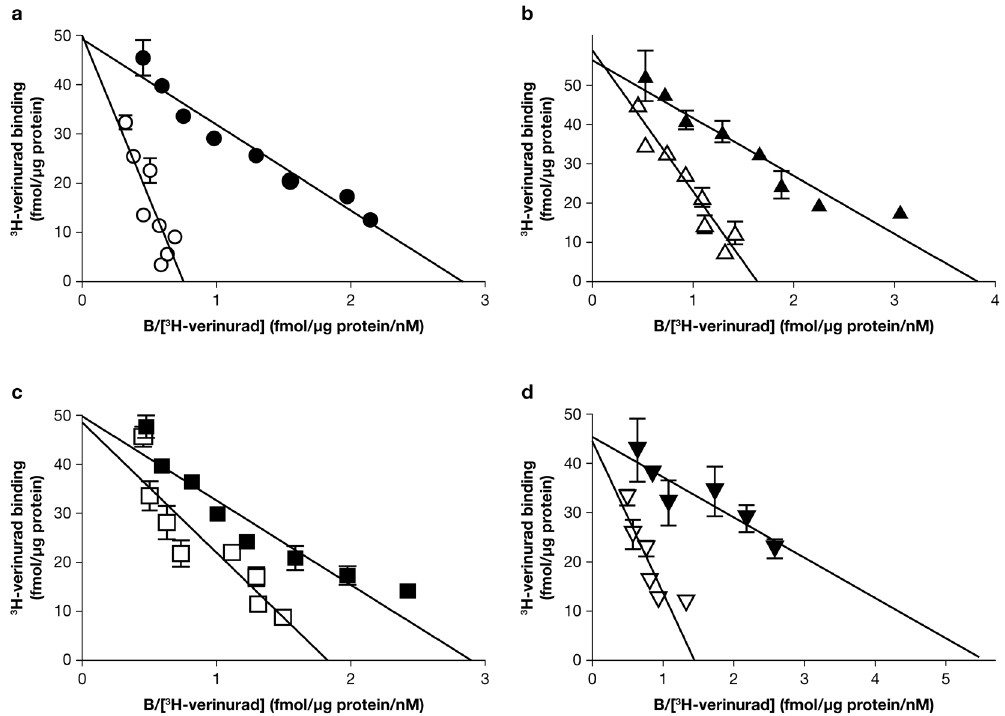
Figure 8. Inhibitors bind to the same binding site on URAT1. Binding of 3 H-verinurad to human URAT1 in the absence of inhibitors (filled symbols) or in the presence of 20 nM unlabeled verinurad ( a ) (open circles), 50 nM benzbromarone ( b ) (open upward triangles), 25 µ M sulfinpyrazone ( c ) (open squares) or 200 µ M probenecid ( d ) (open downward triangles). Membranes containing human URAT1 were incubated with different concentrations of 3 H-verinurad without or with inhibitors. Specifically bound 3 H-verinurad is shown by Eadie- Hofstee linearization. B = bound